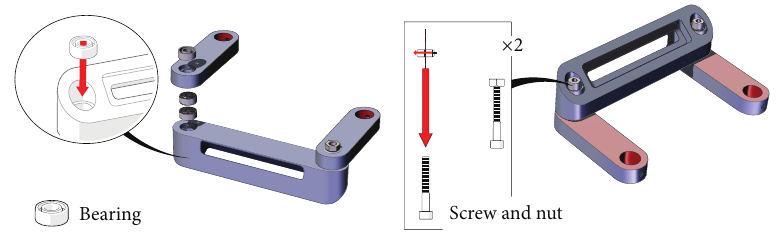
Figure 10: Double-crank linkage design.